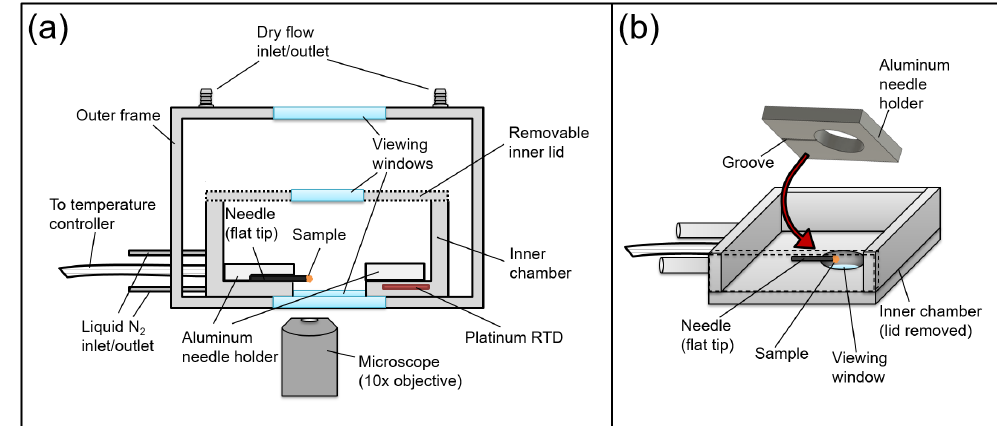
Figure 2. Schematic of the hot-stage microscopy apparatus, where panel (a) is a cross-section of the whole apparatus and panel (b) shows a perspective view of the inner chamber of the temperature control stage.